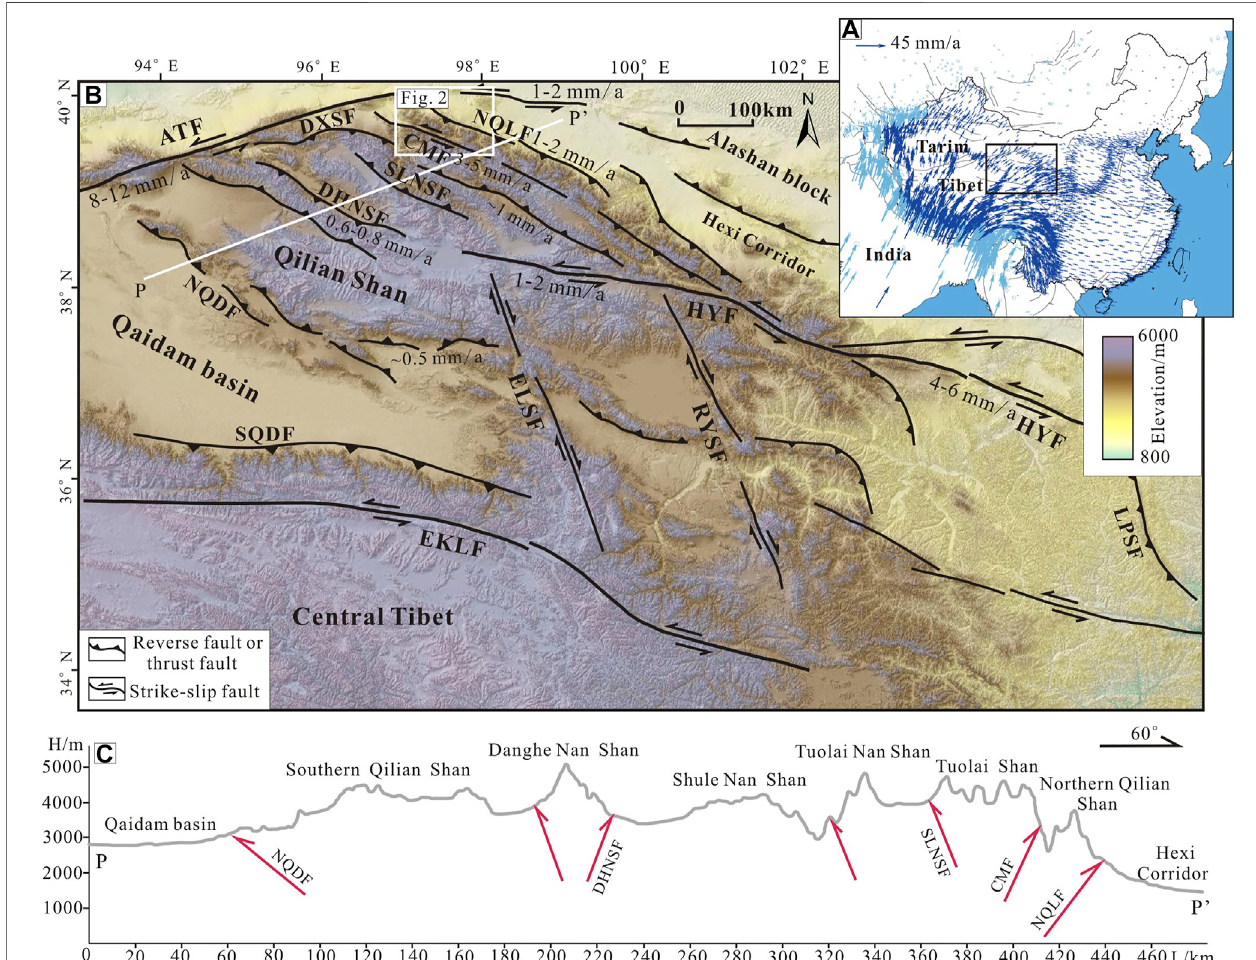
FIGURE 1 | (A) GPS velocity fi eld of the China mainland (modi fi ed from Wang and Shen, 2020). (B) The tectonic map of the northeastern Tibetan Plateau showing themainactivefaultsand itssliprates.Therangeofthemapisshownintheblackrectangleofpanel (A) . (C) Thetopographicpro fi leacrossthewesternQilianShan.The location of the pro fi le is the white line P-P ’ in panel (B) . Abbreviations of names: ATF, Altyn Tagh fault; CMF, Changma fault; DHNSF, Danghe Nan Shan fault; DXSF, Daxue Shan fault; ELSF, Ela Shan fault; EKLF, Eastern Kunlun fault; NQDF, Northern Qaidam fault; NQLF, Northern Qilian fault; HYF, Haiyuan fault; LPSF, Liupan Shan fault; RYSF, Riyue Shan fault; SLNSF, Shule Nan Shan fault; SQDF, Southern Qaidam fault.